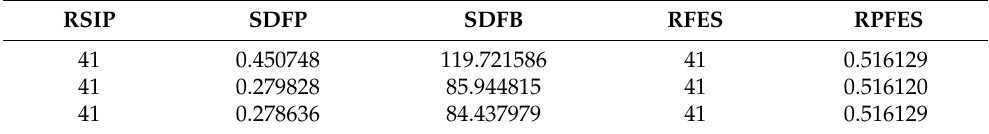
Table 1. Characteristics of the traffic features.